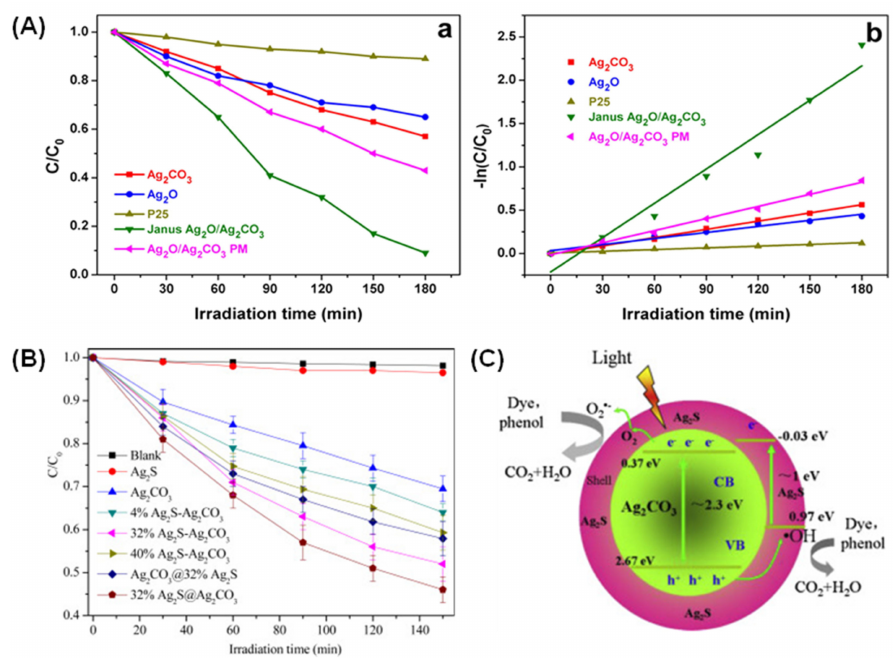
Figure 8. ( A ) ( a ) Comparison of the photocatalytic activities in the decomposition of 4-CP over the prepared samples under visible-light illumination and ( b ) pseudo first-order kinetics. Reproduced with permission from [92]. ( B ) Photocatalytic activity comparison of the prepared photocatalysts in the degradation of phenol. ( C ) The mechanism of enhanced photocatalytic performance in Ag 2 S@Ag 2 CO 3 . Reproduced with permission from